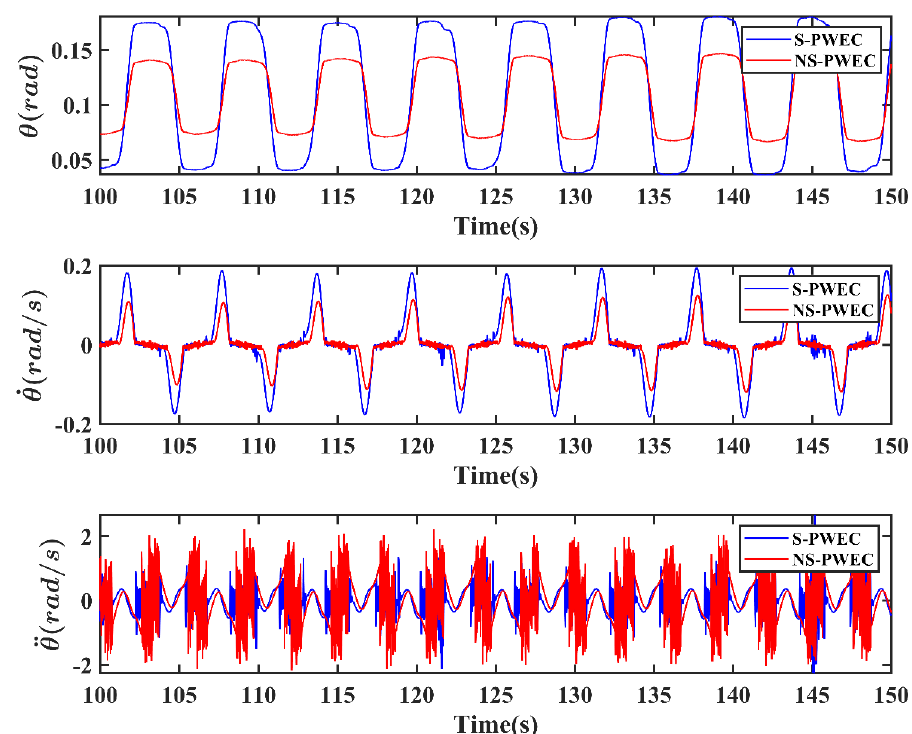
Figure 6. Motion Response of S-PWEC and NS-PWEC.